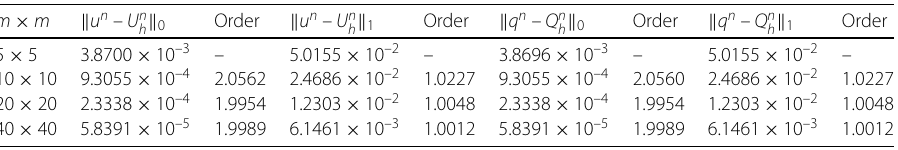
and Q n when t = 0.5 ( τ = 5 h 2 ) h h